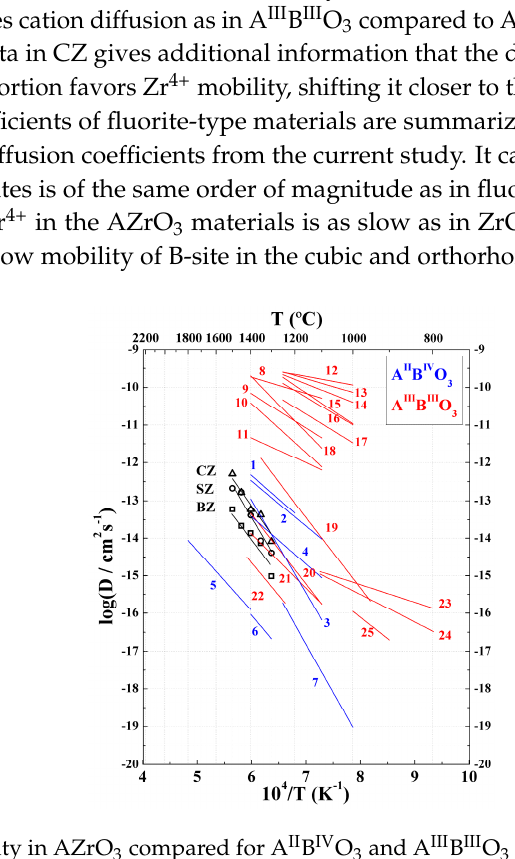
Figure 7. Zr diffusivity in AZrO 3 compared to data diffusion data in fluorites. Abbreviations: p—polycrystalline; sc—single crystal; c—cubic; t—tetragonal; b—bulk; gb—grain boundaries. (1) 96 Zr in c-ScSZ gb [36]; (2) Yb in t-YSZ gb [49]; (3) Hf in t-YSZ gb [49]; (4) Fe in (Gd,Ce)O 2 [50]; (5) Co in (Gd,Ce)O 2 [50]; (6) La in (La,Ce)O 2 [50]; (7) Co in (La,Ce)O 2 [50]; (8) Sr in (Gd,Ce)O 2 [51]; (9) Sr in